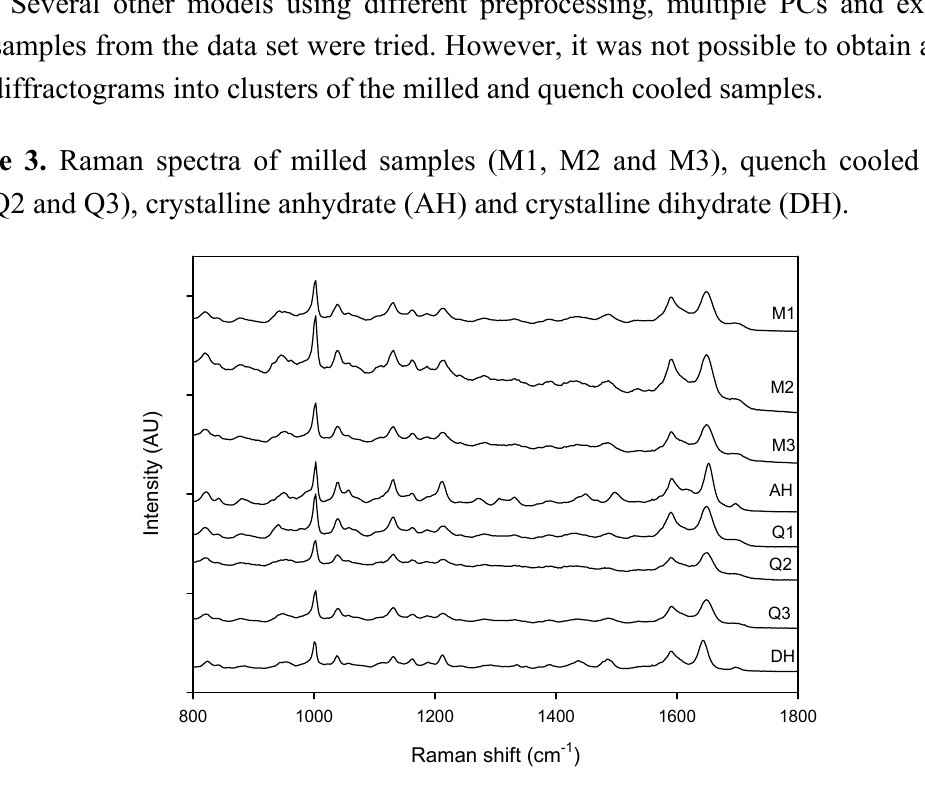
Figure 4. Magnification of the 1500 cm − 1 to 1700 cm − 1 spectral region. Milled samples (M1, M2 and M3), quench cooled samples (Q1, Q2 and Q3), crystalline anhydrate (AH) and crystalline dihydrate